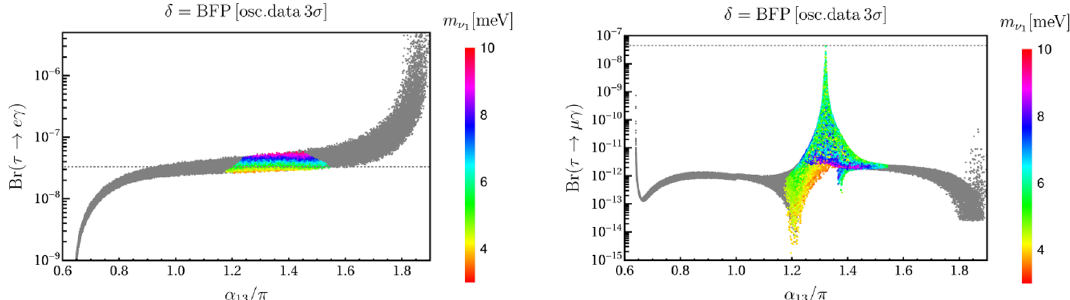
Figure 15 . Br( (cid:28) e(cid:13) ) and Br( (cid:28) (cid:22)(cid:13) ) as functions of (cid:11) 13 for di(cid:11)erent values of the lightest ! ! neutrino mass (color-coded) along with the current experimental limits (dotted line). We scanned over 3 (cid:27) uncertainties of the oscillation data, except for (cid:14) which was (cid:12)xed to the b.f.p. Gray points are excluded due to perturbativity arguments.